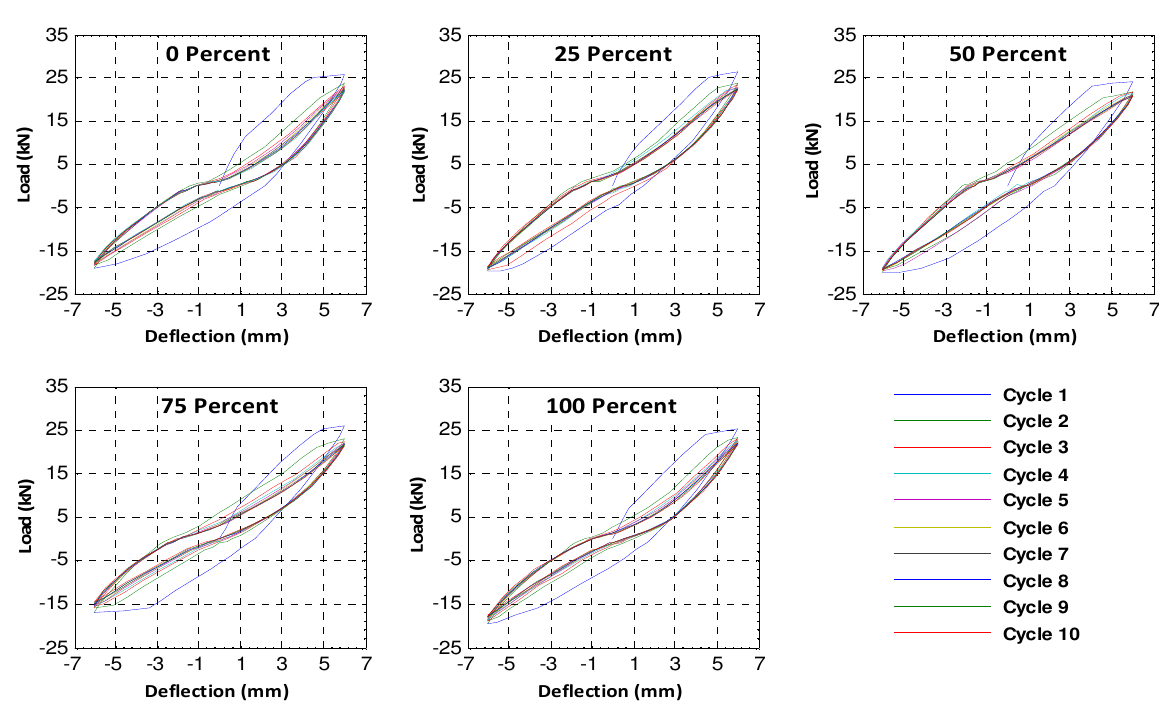
Fig.9: Hysteresis loops (loading cycles of 6 mm